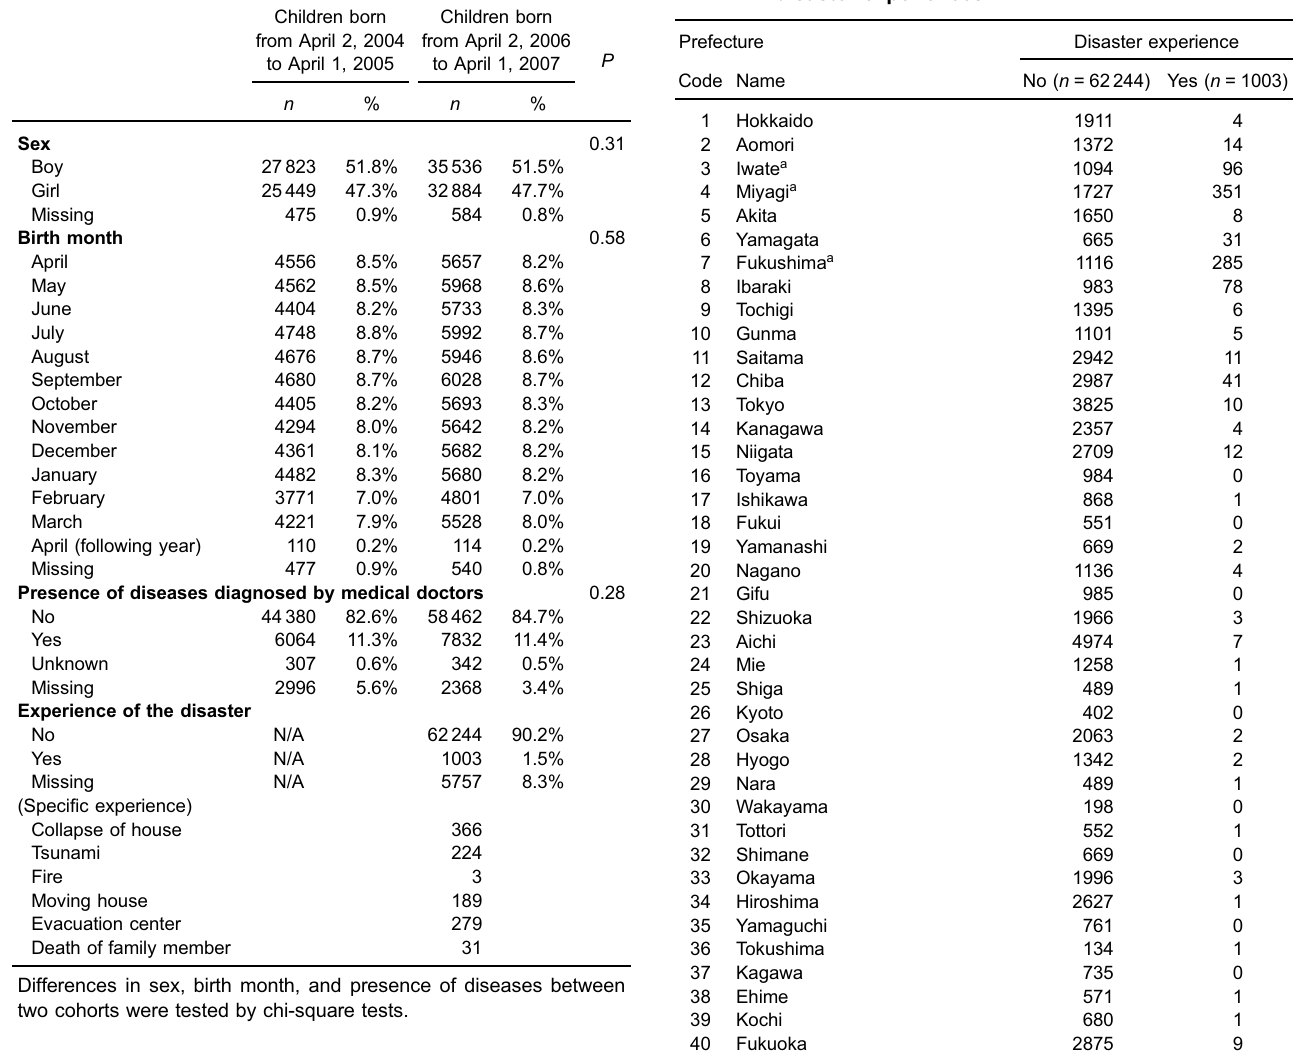
Table 4. Residential distribution of children with personal disaster experiences Prefecture Disaster